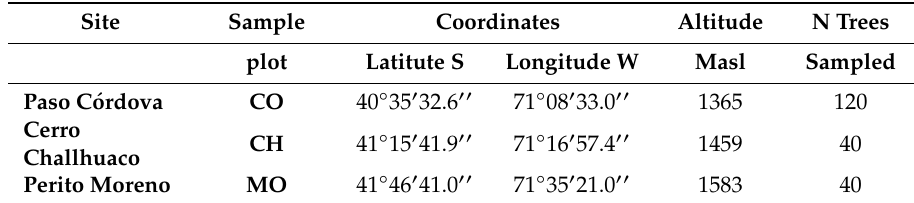
Table 1. N. pumilio study sites. Site name and code, geographical location, altitude, and number of trees sampled at each